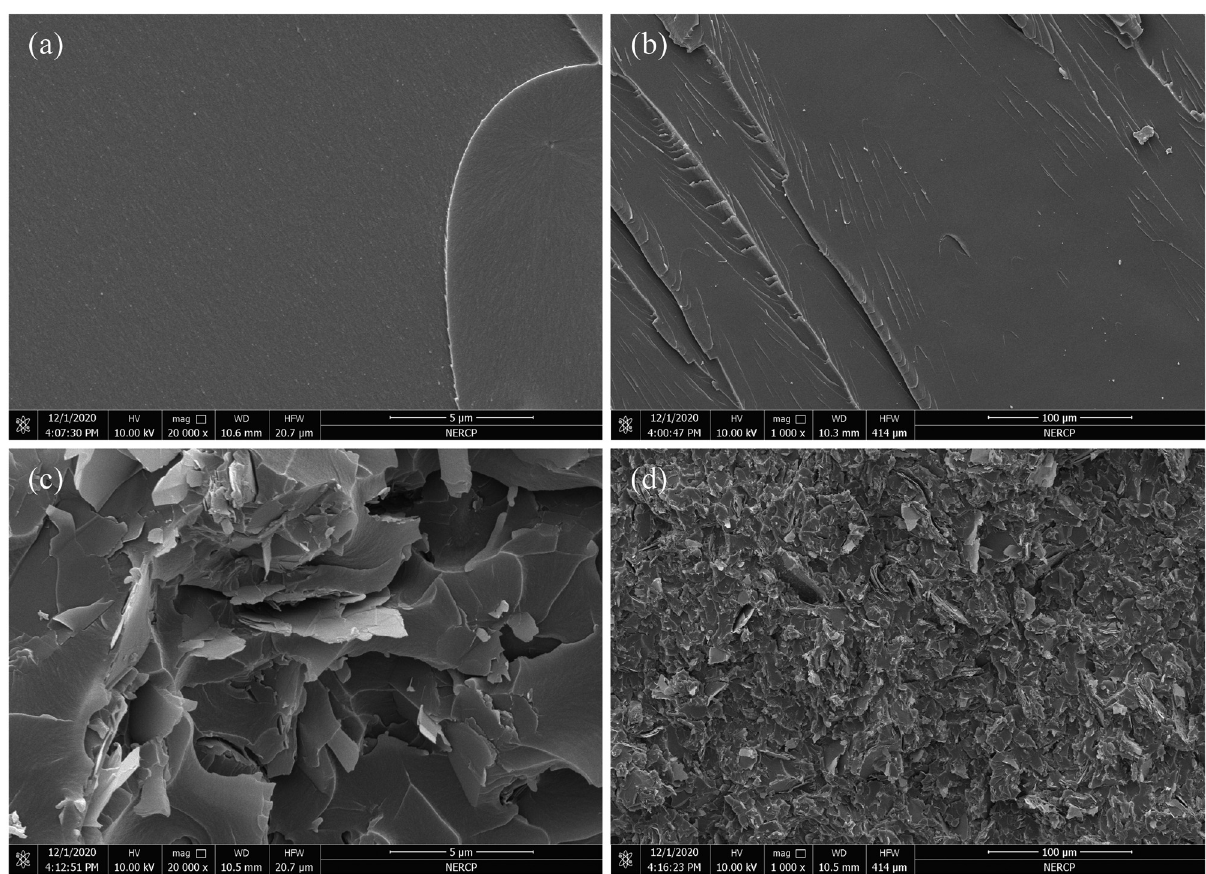
Figure 4: The SEM image of ( a and b ) EP and ( c and d ) h - BN/EP composite with 40 phr h - BN content.